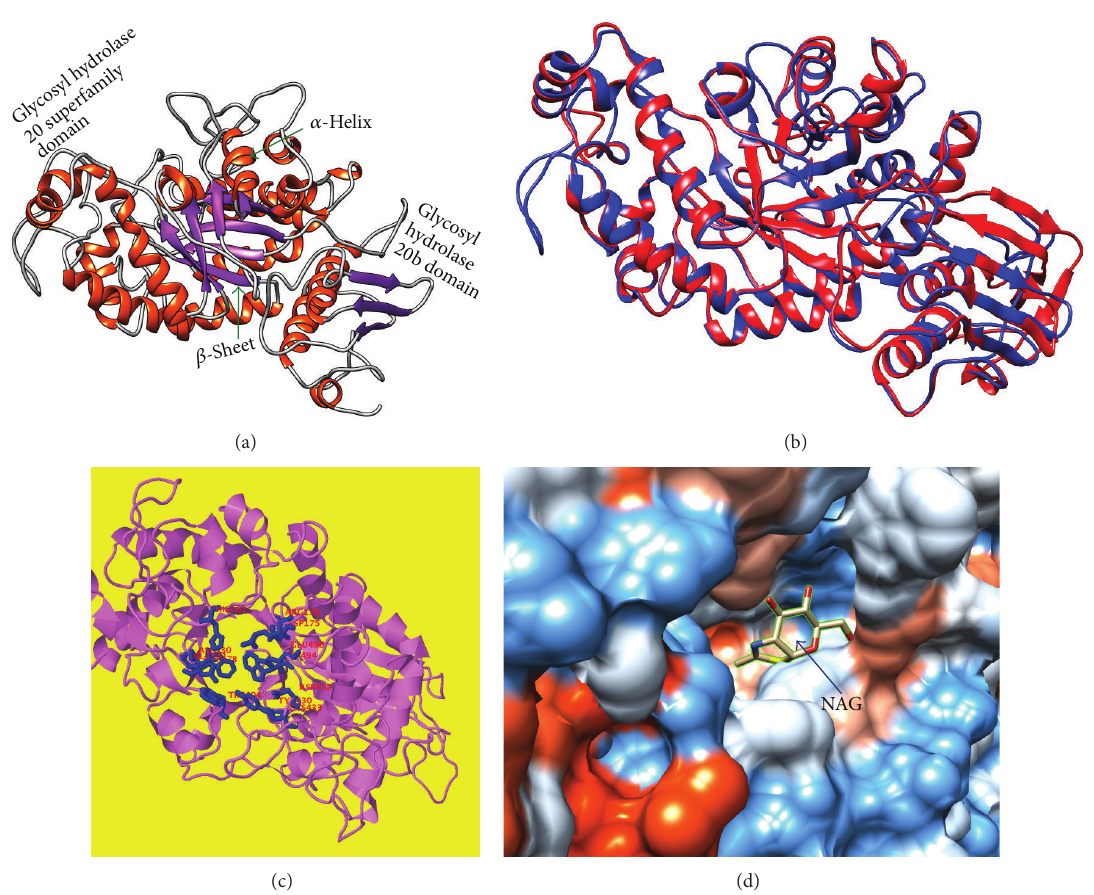
Figure 6: The molecular 3D modeling of tomato beta - 𝑁 -acetyl hexosaminidase ( 𝛽 -Hex-Sl). SPDB viewer and Chimera were used to prepare the images. (a) The predicted 3D modeled structure is shown as ribbon diagram. The structure contains two fold domains (I and II) including 𝛼 -helix (red), 𝛽 -pleated sheets (purple), and coils (gray) The catalytic domain II is a ( 𝛽 / 𝛼 ) 8 barrel with the active site located at the C terminus of the barrel. Template used for building this structure was 1now B(PDB). (b) Superimposition magic fit image of the modeled structure 𝛽 -Hex-Sl (blue) with template structure human 1now, human 𝛽 - 𝑁 -acetyl-hexosaminidase (red), and human 𝛽 -hexosaminidase B-subunit. (c) The predicted ligand-binding site (active site) residues identified are depicted by as blue color. (d) Space filled view of ligand biding site of 𝛽 -Hex-Sl with docking substrate 𝑁 -acetyl- 𝛽 -D-glucosamine